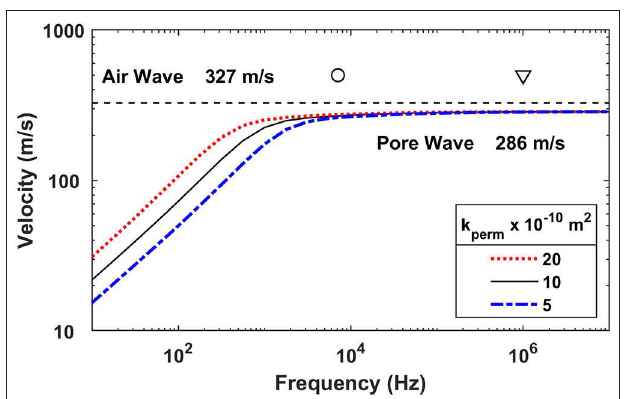
FIGURE 1 | Theoretical behavior of the Biot pore wave, showing the lack of frequency dependence above a critical frequency given by Equation (1), and indicated by the circle at 754Hz. The calculations assumed a porosity of 0.45 and a tortuosity of 1.30. The three lines show the calculated velocity of the pore wave for different values of the snow permeability (5 10 − 10 m 2 , 10 × × 10 − 10 m 2 , and 20 10 − 10 m 2 ). Our measurements were conducted at 90kHz × (indicated by the triangle), well above the frequency dependent band for any snow